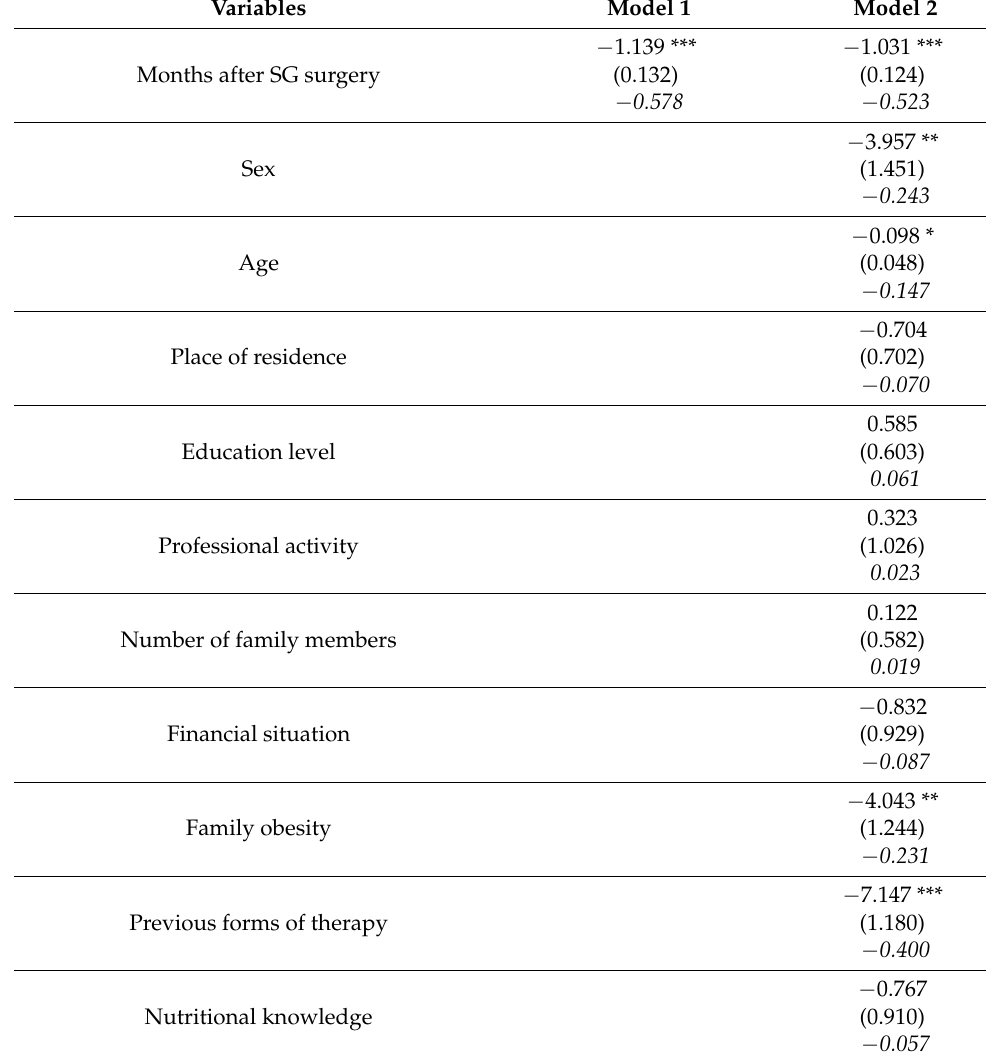
Table 5. Association between BMI and factors affecting BMI variation in patients within 9 months of